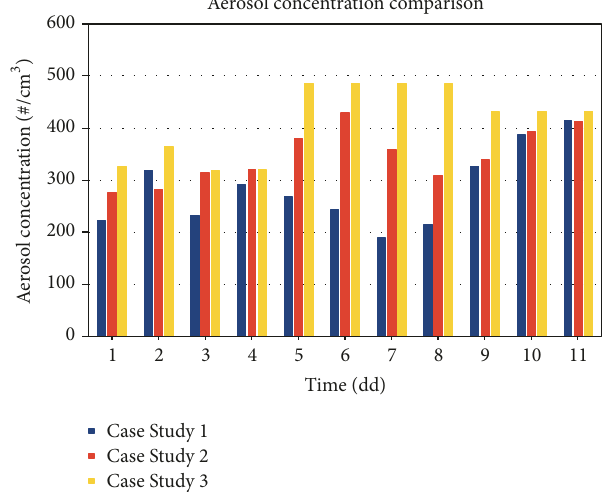
Figure 16: Plot of aerosol concentrations for the three case studies.